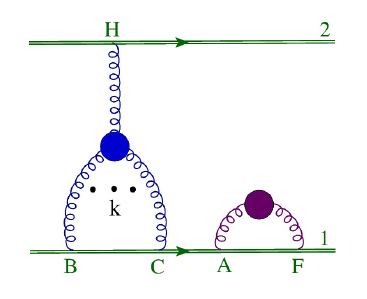
Figure 23. Diagram of the general Cweb W (1 , 1)